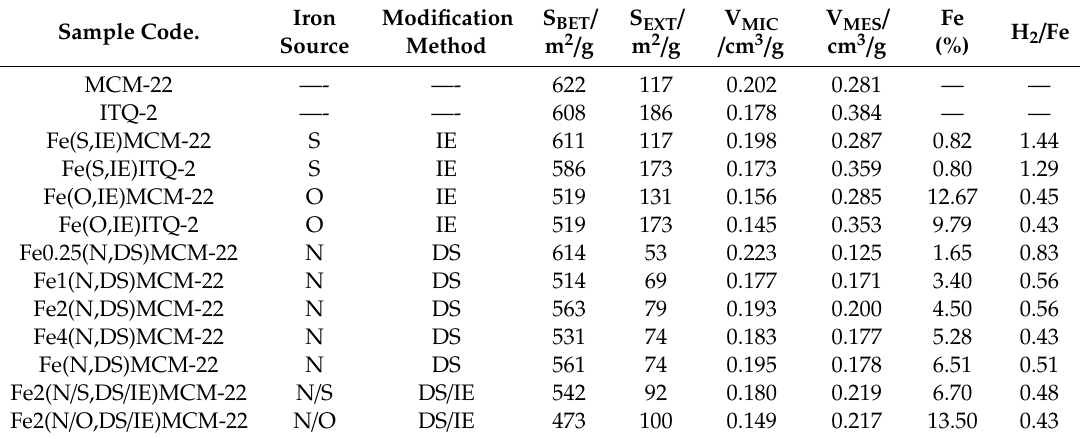
Table 1. Textural parameters determined by N 2 sorption, iron content measured by ICP-OES, and H 2 / Fe ratio estimated based on H 2 -TPR. Iron Sample Code. Source